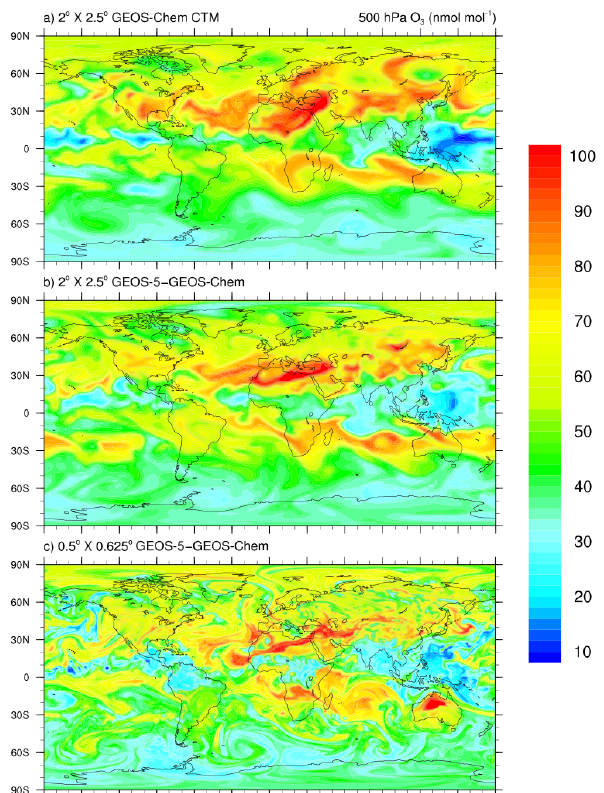
Figure 3. Instantaneous 500hPa ozone mixing ratios (nmolmol − 1 ) at 12:00UT on 15 July 2006, for CTM and ESM implementations of GEOS-Chem. Top panel: GEOS-Chem CTM at 2 ◦ × 2 . 5 ◦ res- olution driven by GEOS-5 assimilated meteorological data with 0 . 5 ◦ × 0 . 67 ◦ resolution. Middle panel: GEOS-5–GEOS-Chem ESM at 2 ◦ × 2 . 5 ◦ resolution. Bottom panel: GEOS-5–GEOS-Chem ESM at 0 . 5 ◦ × 0 . 625 ◦ resolution. All three simulations are initialized with the same GEOS-Chem CTM fields at 00:00UT on 1 July 2006, but the ESM as implemented here does not include meteorological data assimilation.